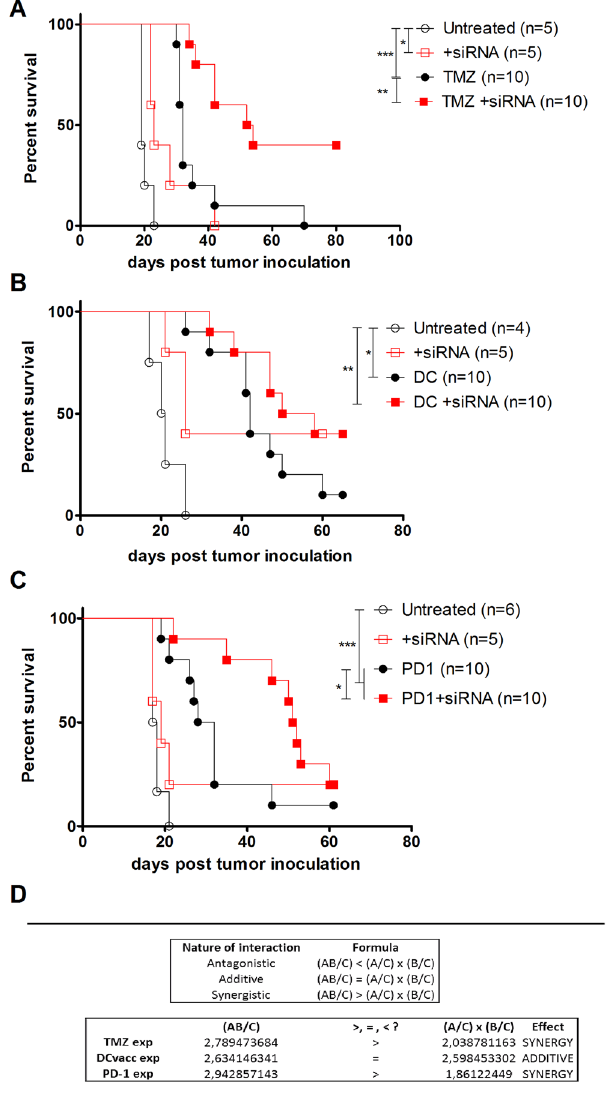
Figure 3. Survival benefit of siGal-1 in combination with chemo- and immunotherapy. Mice were inoculated with 0.5 × 10 6 GL261 cells which induce a lethal GBM after 15–20 days. Combination strategy with ( A ) TMZ was organized by siGal-1 administration at day 2, 4, 7 and 11 after tumor inoculation prior to TMZ administration at day 8, 11 and 15, at a dose of 40 mg/kg. For combination with immunotherapy, DC vaccination ( B ) and PD-1 blocking ( C ) were included. In ( B ), mice received monotherapy siGal-1 as described in Fig. 1A (open red squares), prophylactic DC vaccination at day − 14 and − 7 before tumor inoculation (200 µ g lysate/million DCs, IP, black dots), or the combination of DC vaccination and siGal-1 (closed red squares). In ( C ), mice received anti-PD-1 mAb at day 7 and 12 after tumor inoculation (100 µ g/day, IP, black dots) or the combination of PD-1 blocking and siGal-1 (closed red squares). Curves were compared by Log-Rank survival analysis. (n = as indicated, * p < 0.05, ** p < 0.01 and *** p < 0.001). ( D ) Based on median survival data (from Fig. 3A,B and C), the calculations for antagonistic effect, additive effect and synergistic effect were carried out based on the Robert Clark Equations 29 ; where A = response to treatment 1 ( = siGal-1), B = response to treatment 2 ( = TMZ, DCvacc or anti-PD-1), AB = combination groups and C = response to no treatment ( =